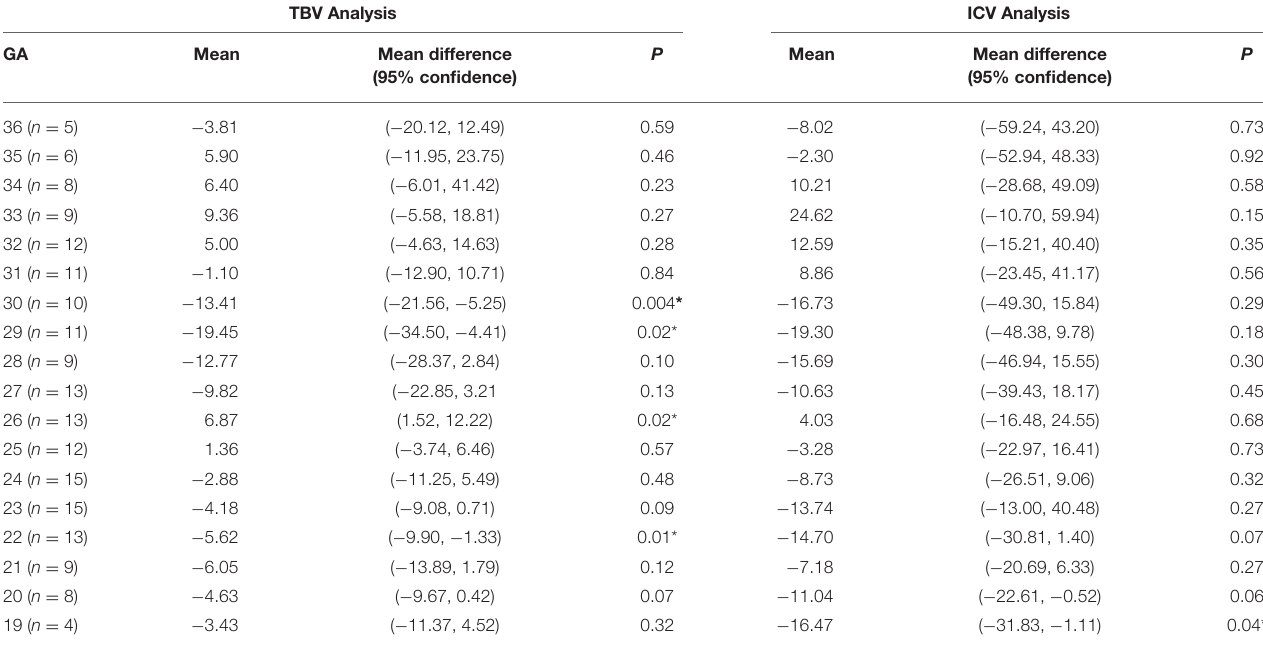
TABLE 2 | Total brain volume and ICV analysis compared with values reported by Jarvis’